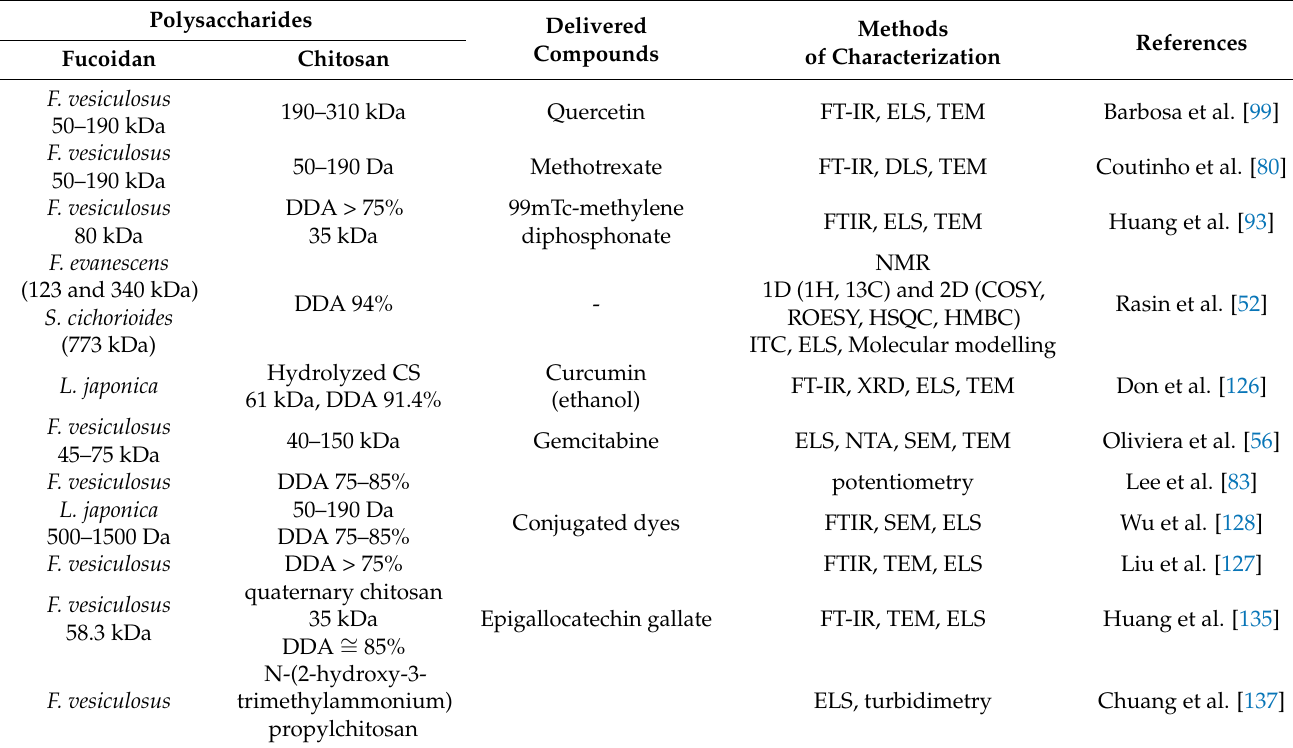
Table 1. Methods applied for the characterization of FUC–CS